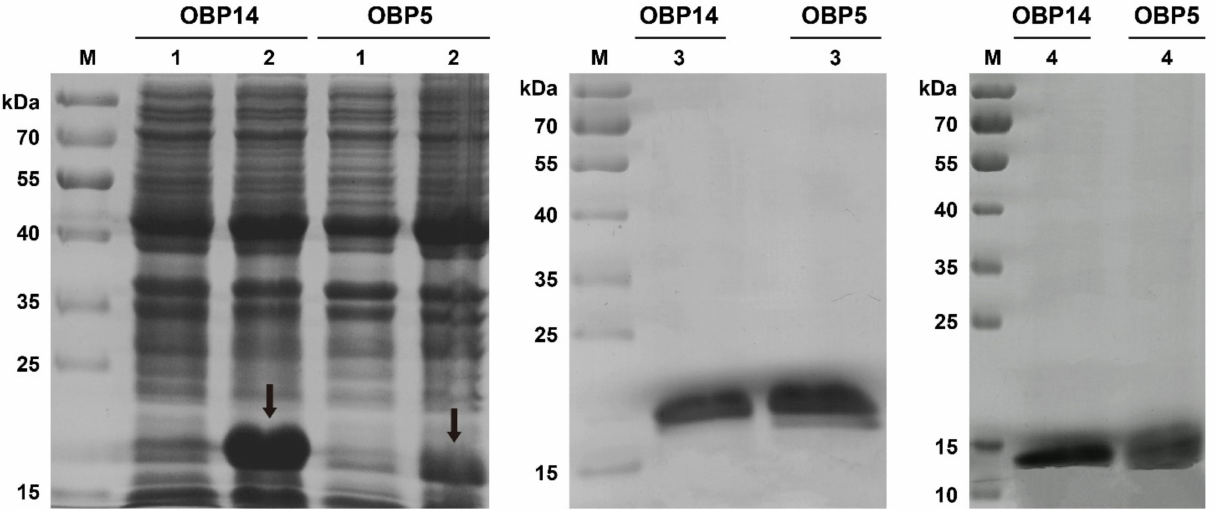
Figure 3. Expression and purification of two DabiOBPs in D. abietella , as indicated by SDS–PAGE. The crude bacterial extracts before (lane 1) and after (lane 2) IPTG induction, respectively. The purified recombinant proteins pET–30a (+)/DabiOBPs with the His-tag (lane 3). Re-purification of DabiOBPs after the removal of the His-tag (lane 4). M: Protein molecular weight marker. Arrows indicate induced target proteins pET–30a